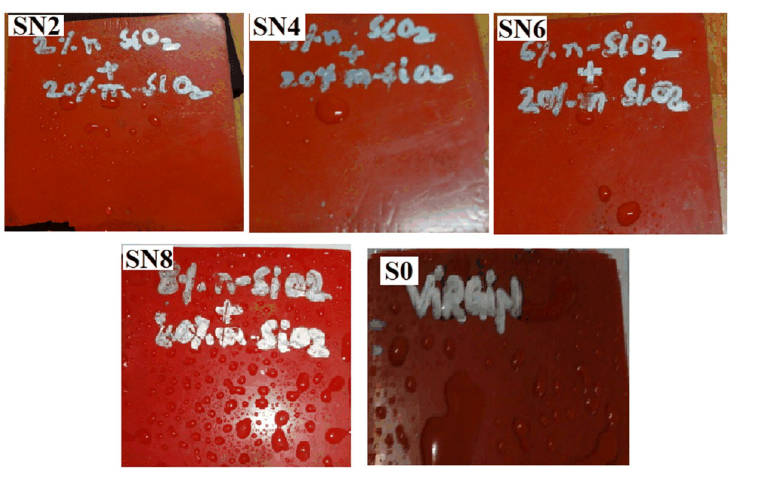
Fig 8. HC after 9000 hours of aging.